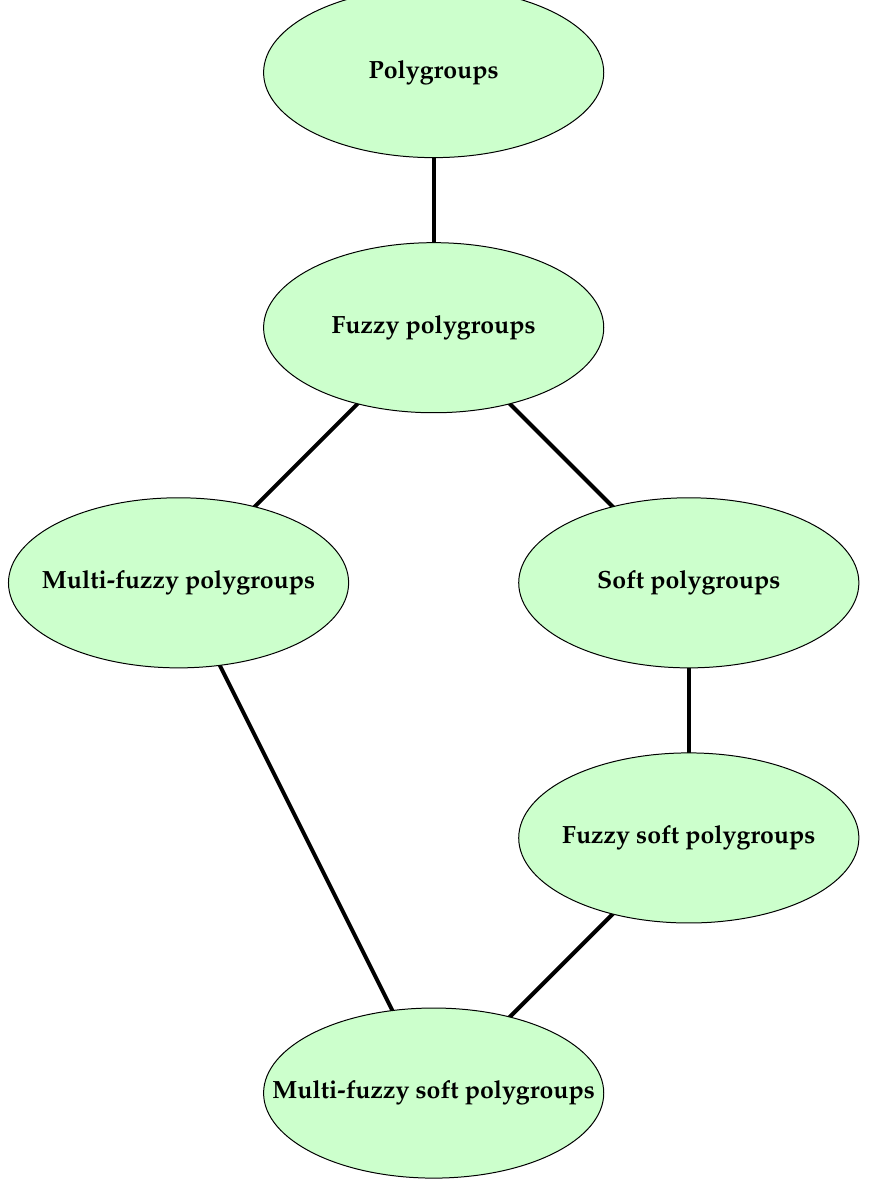
Figure 2. The relation between generalizations of